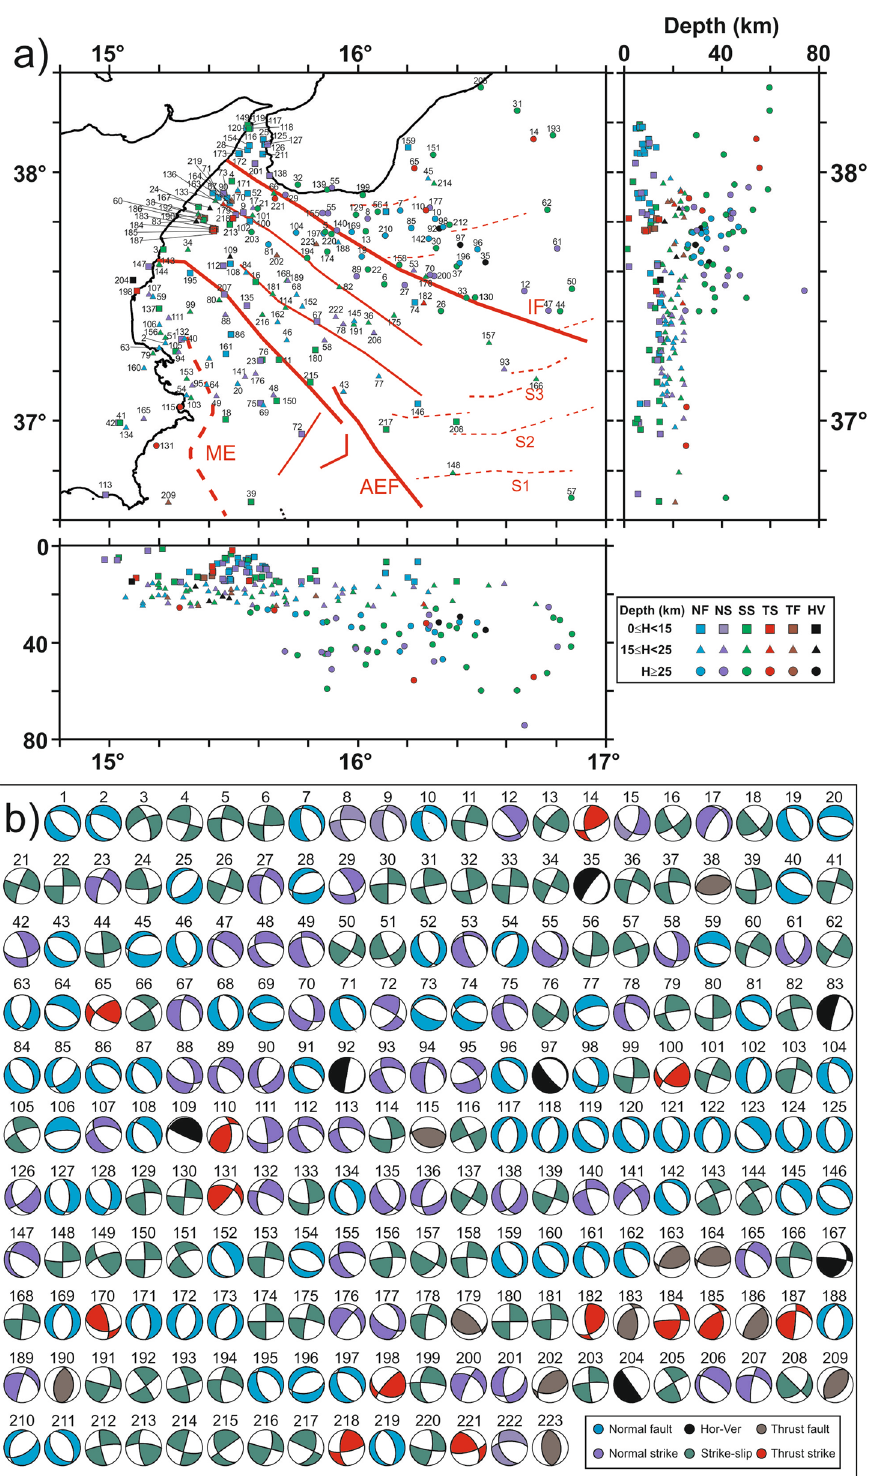
Figure 4. ( a ) Location map and EW and NS sections for the new 223 focal mechanisms computed in this study. The different colours of the epicenters refer to the kinematic classification 35 based on the plunge of T and P axes (Fig. S2). Squares, triangles and circles indicate the three depth ranges of events (0–15 km; 15–25 km; > 25 km; see legend in the bottom right inset). Main geological features including Alfeo–Etna Fault (AEF) and Ionian Fault (IF) systems 11 , Malta escarpment (ME) and splay faults (S1, S2, S3) are sketched in red. ( b ) The new 223 focal solutions computed in this work. Map and sections were created using the software Surfer (Version 8.09.2391; http://www.golde nsoft ware.com/produ cts/surfe r); ( a , b ) were edited using Corel Draw 2018 (Version 20.0.0.633; http://www.corel